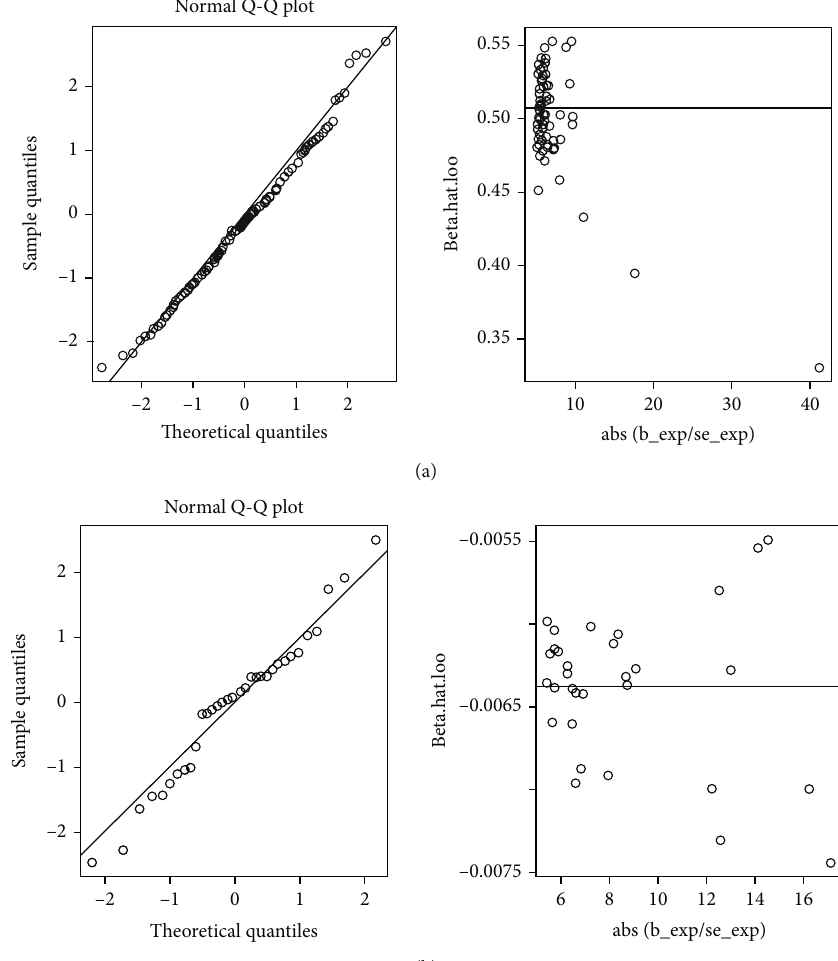
Figure 3: Diagnostic plots generated by MR-RAPS. (a) Causal role of SLE on 25-hydroxyvitamin D levels (model 1). (b) Causal role of SLE on 25-hydroxyvitamin D levels (model 2). SLE: systemic lupus